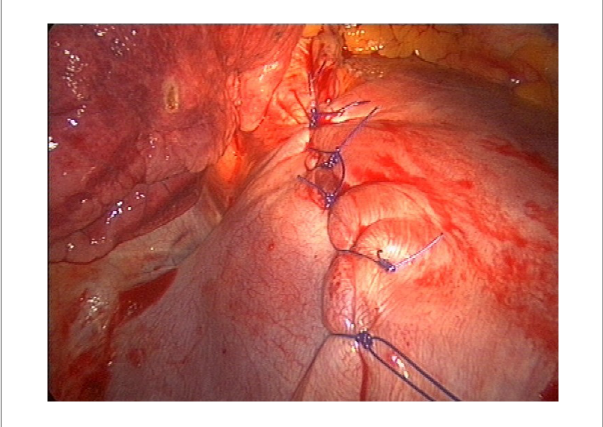
FIGURE 5 Selective diaphragmatic plication for VATS intraoperative fi nding of diaphragmatic fenestrations. VATS, video-assisted thoracic